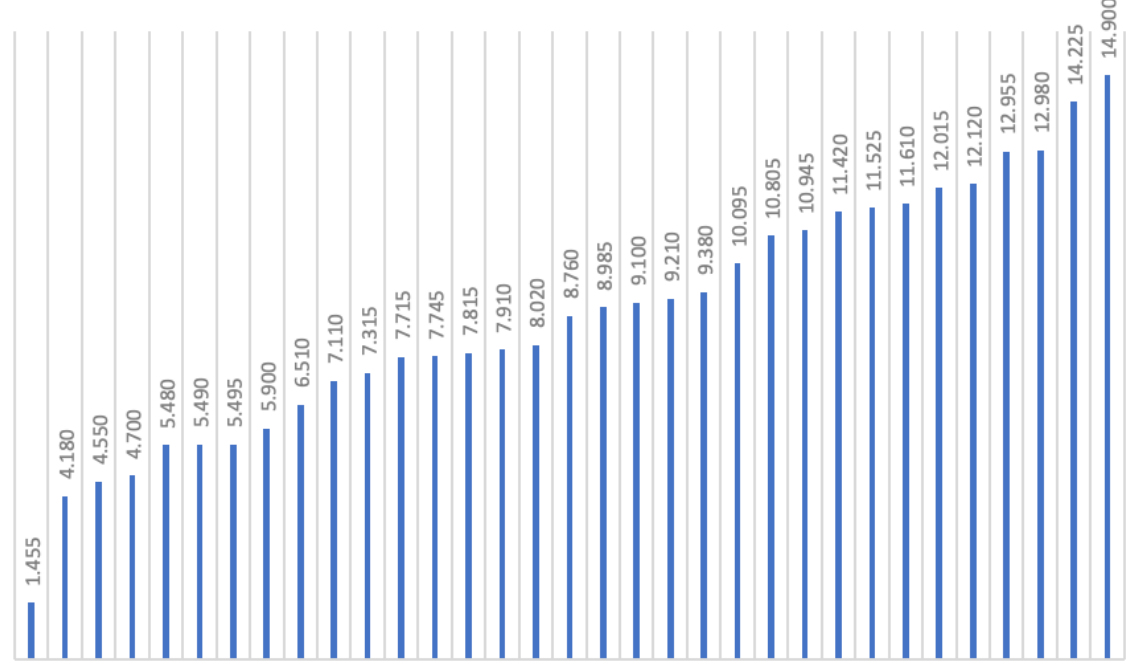
Figure 7. The weight of the studied miniature columns from Gonur